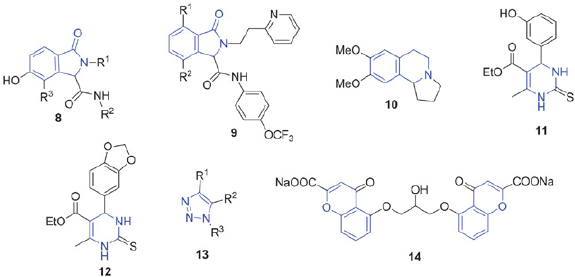
Figure 2. Biologically active N - and O -heterocyclic derivatives